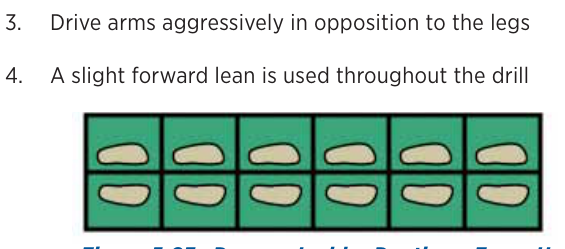
Figure 5-23. Rope or Ladder Routine – Every